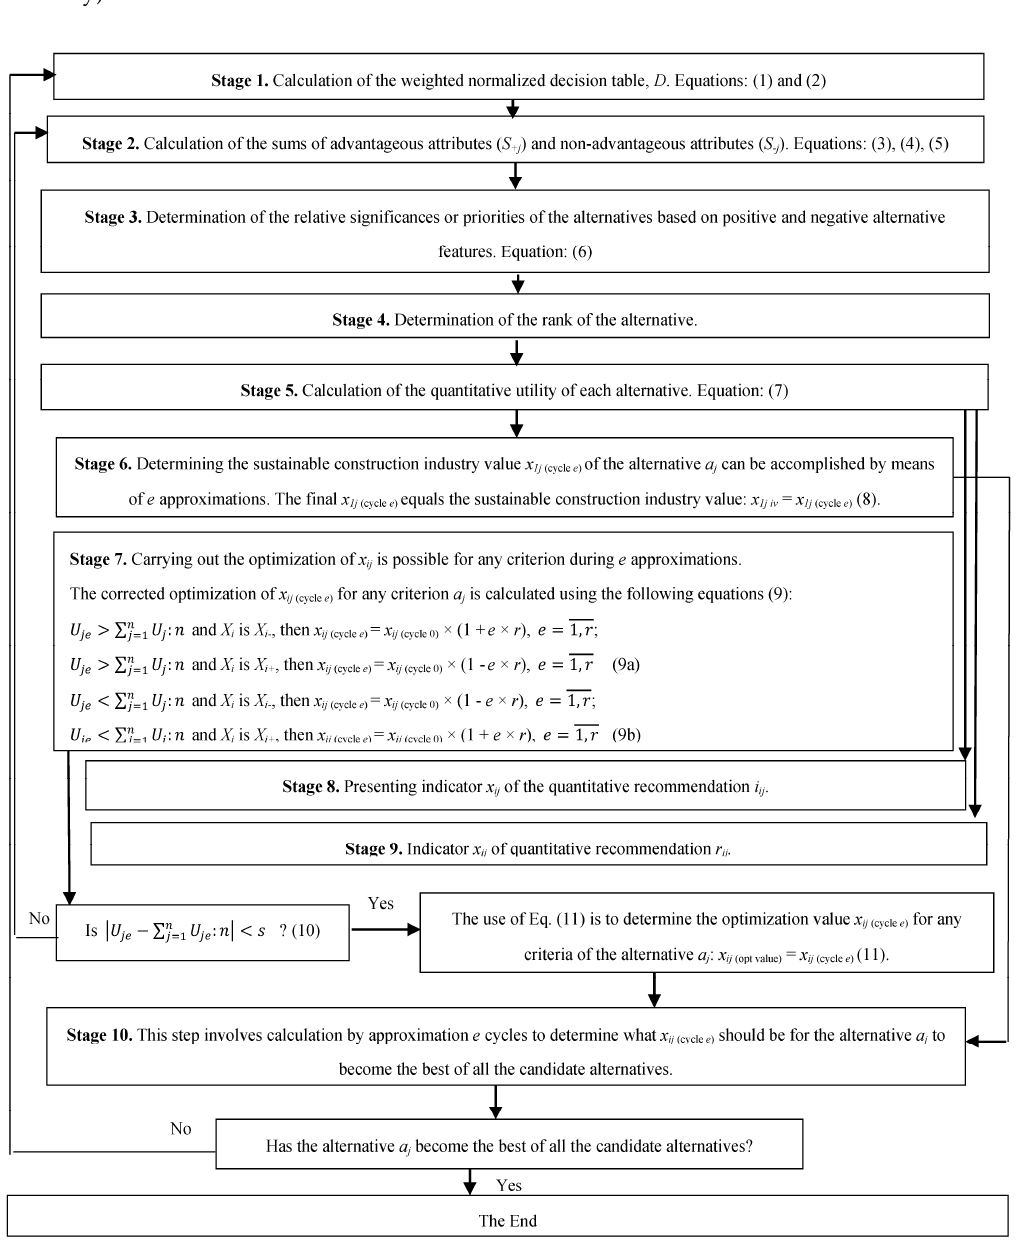
Figure 1. Degree of Project Utility and Investment Value Assessments (INVAR) method.